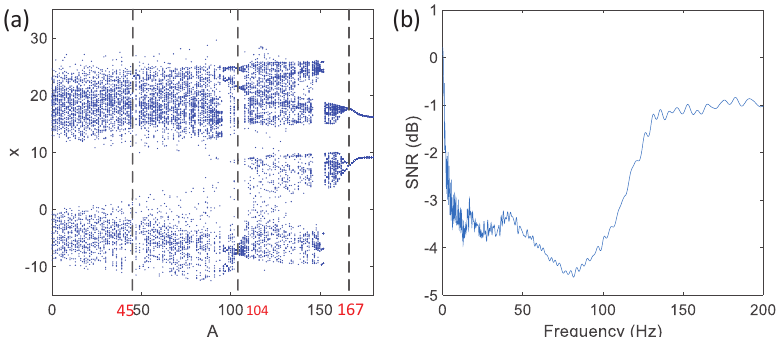
Figure 5. ( a ) Bifurcation diagram of the amplitude of the sinusoidal signal A ; ( b ) the SNR curve with frequency variation.